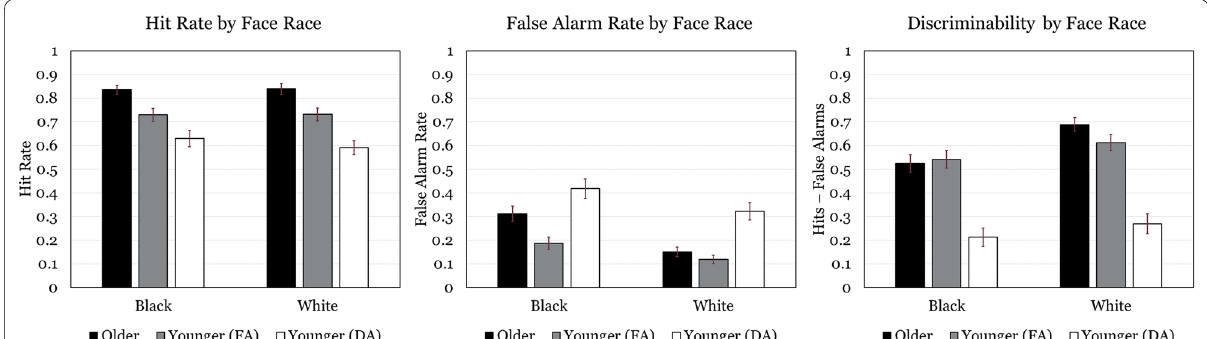
Fig. 3 Hit rate, false alarm rate, and average discriminability for each face type and age/attention group. FA